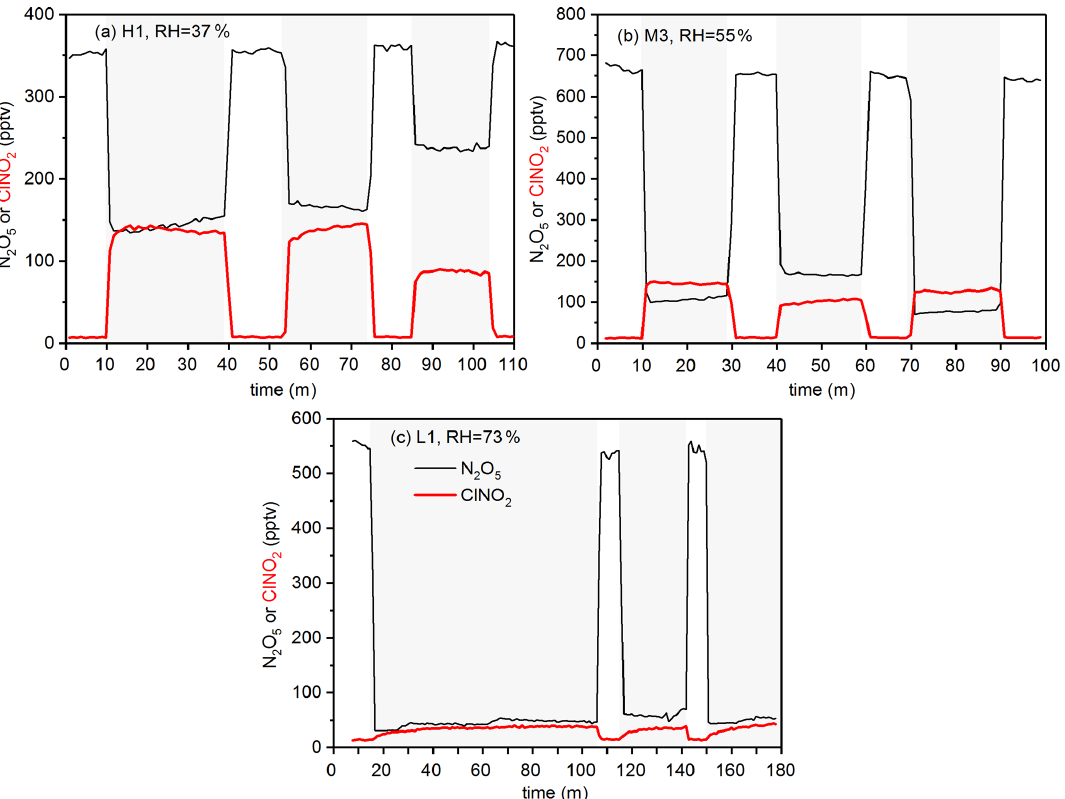
Figure 2. Time series for measured N 2 O 5 and ClNO 2 concentrations after the mixed flow was passed through the blank filter or the particle- loaded filter: (a) H1, 37% RH; (b) M3, 55% RH; (c) L1, 73% RH. Periods in which the mixed flow was passed through the particle-loaded filter are shaded